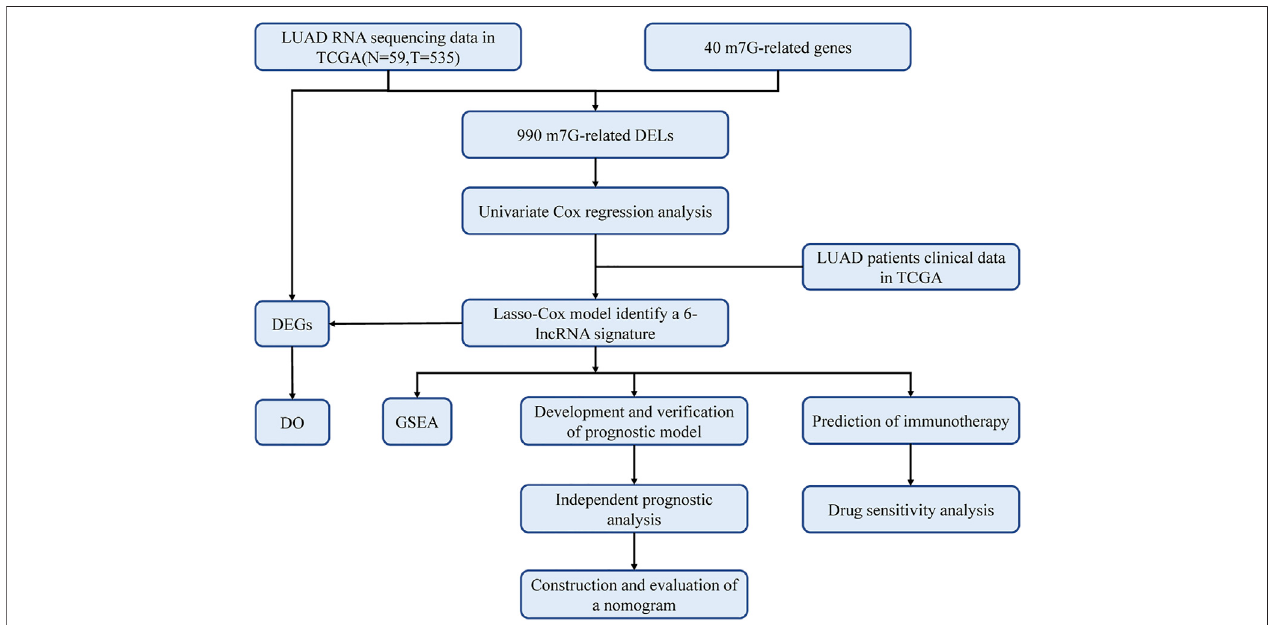
FIGURE 1 | Work fl ow of this study. The TCGA database was utilized to screen 990 differentially expressed lncRNAs (DELs) in LUAD, which were analyzed with LASSO-COX regression to develop a prognostic model for m7G-related lncRNAs. The prognostic model had been validated in multiple ways and proved to be stable and reliable. Therefore, based on this model, we also performed disease ontology enrichment analysis (DO), gene set enrichment analysis (GSEA), immune-related analysis and drug sensitivity analysis to determine the potential function of prognostic